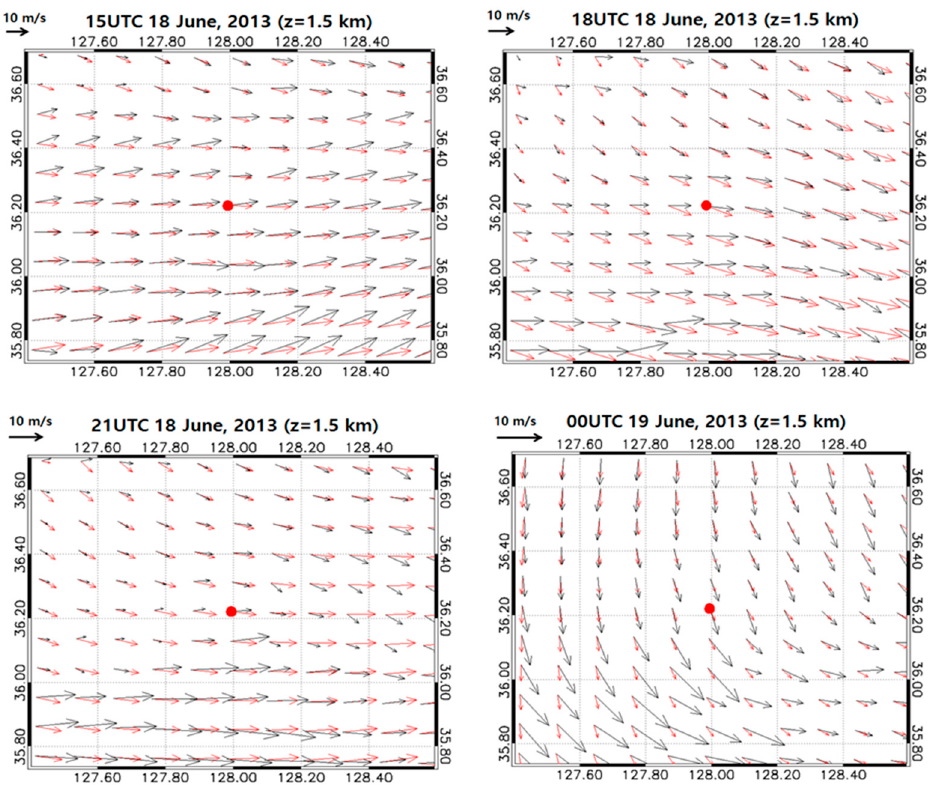
Figure 13. Wind vector from WPR3D (red) and LDAPS (black) at the 1.5-km level. P0 is shown by the red point in the center.